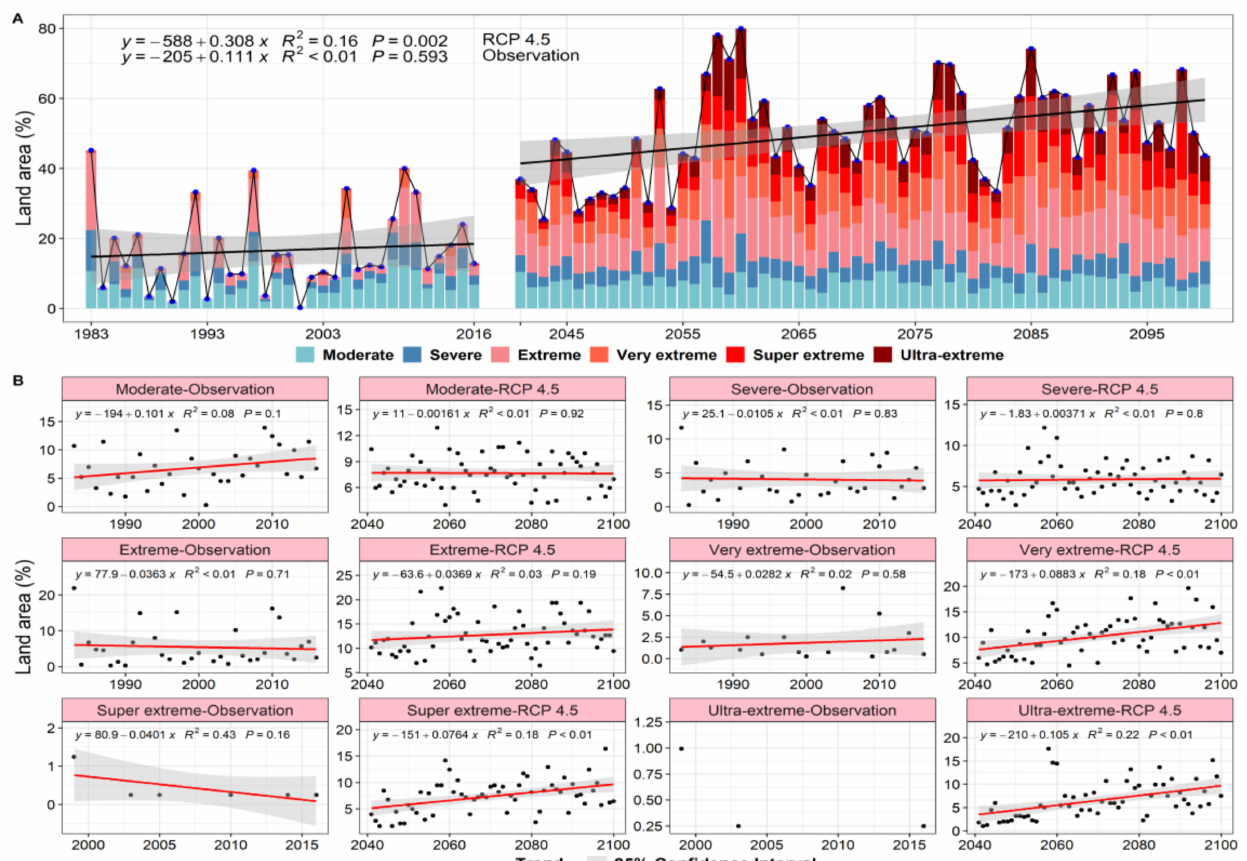
Figure 7. Temporal evolution of land area ratio, expressed in percentages: ( A ) trends of the land area ratio, ( B ) regression analysis of the various heatwave categories that occurred in Tanzania from